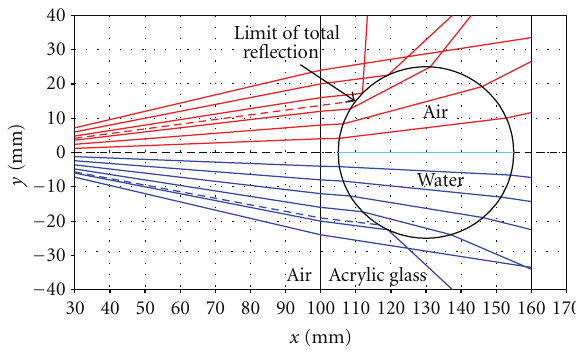
Figure 3: Scheme of the simulated optical path through the hot leg cross-section (distance between camera and channel outer wall: 100 mm).